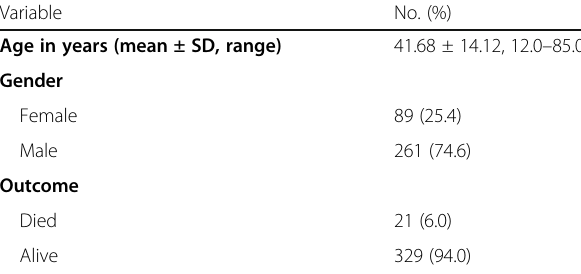
Table 2 The distribution and frequency of the radiographic